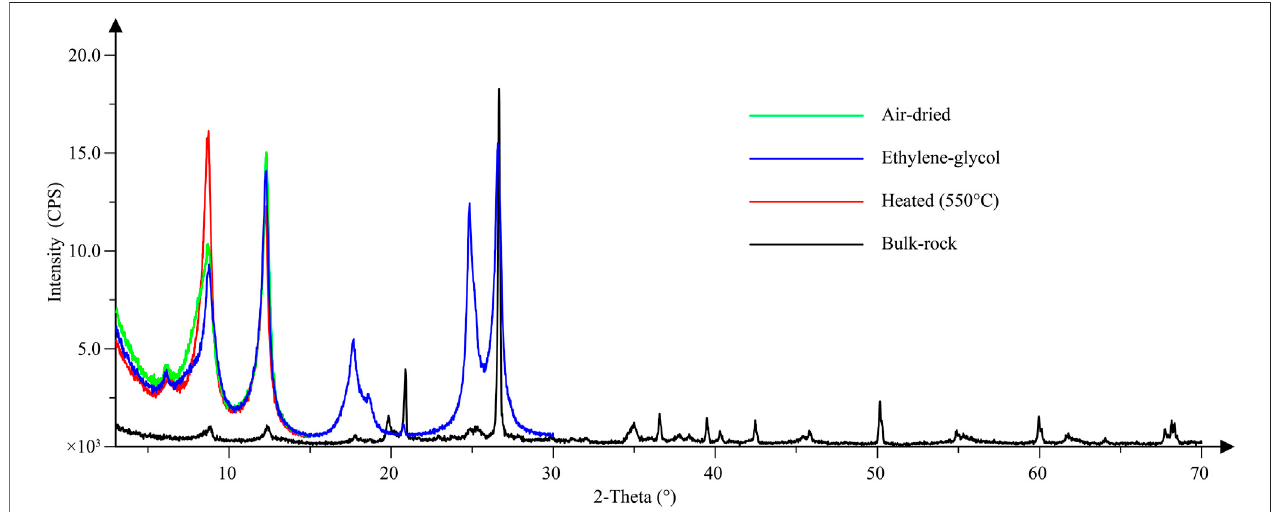
FIGURE 9 | Graph showing the XRD patterns of sample